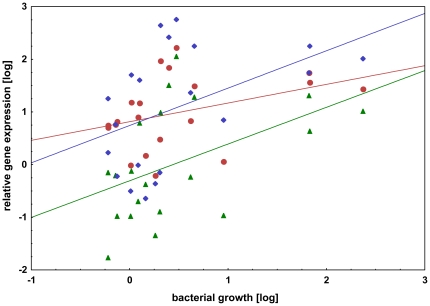
Antimicrobial peptide gene expression depending on bacterial growth.Correlation analysis between relative bacterial growth and relative gene expression of abaecin (red), defensin 1 (green) and hymenoptaecin (blue). Each data point represents one individual bumble bee with individual bacterial load and AMP expression (both were plotted with log-transformed values). Significant correlations were detected for defensin 1 (r = 0.4720, p = 0.0356) and hymenoptaecin (r = 0.4546, p = 0.0441), not abaecin (r = 0.3754, p = 0.1038).